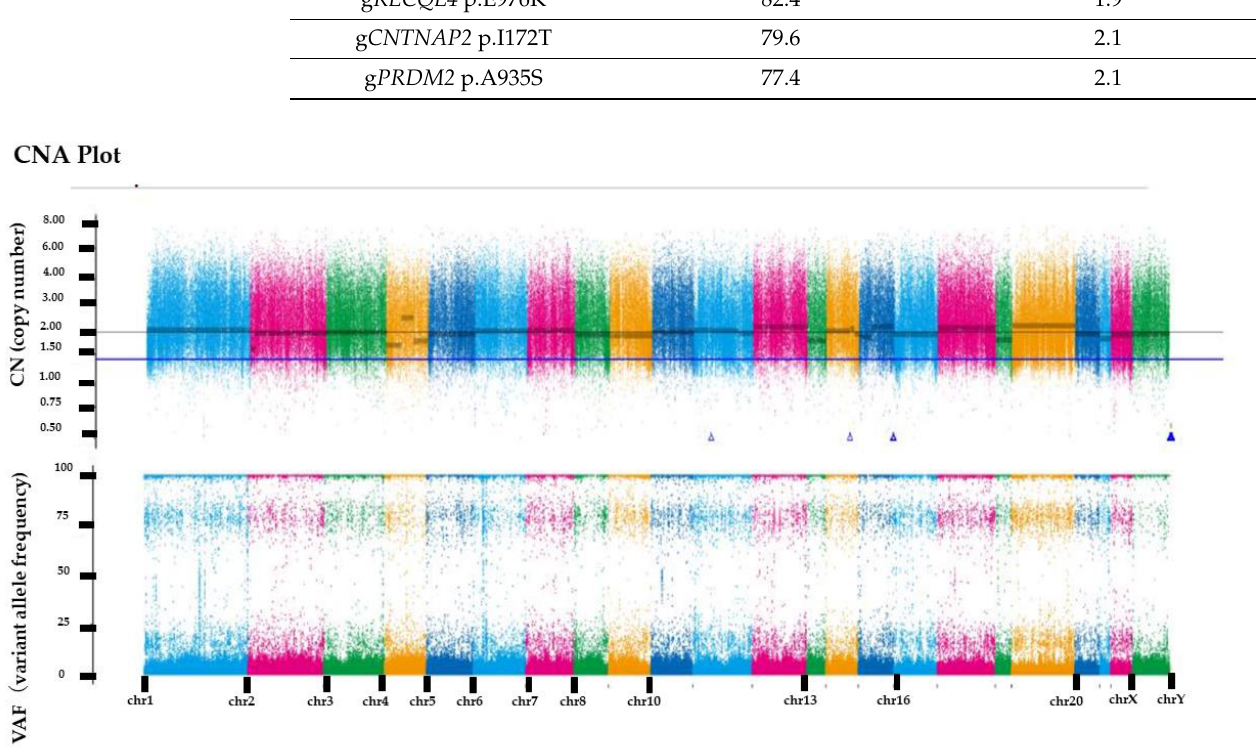
Figure 4. Copy number alteration plot (CNA plot). The horizontal axis represents the position of the chromosome and the vertical axis represents the copy number of the genes.